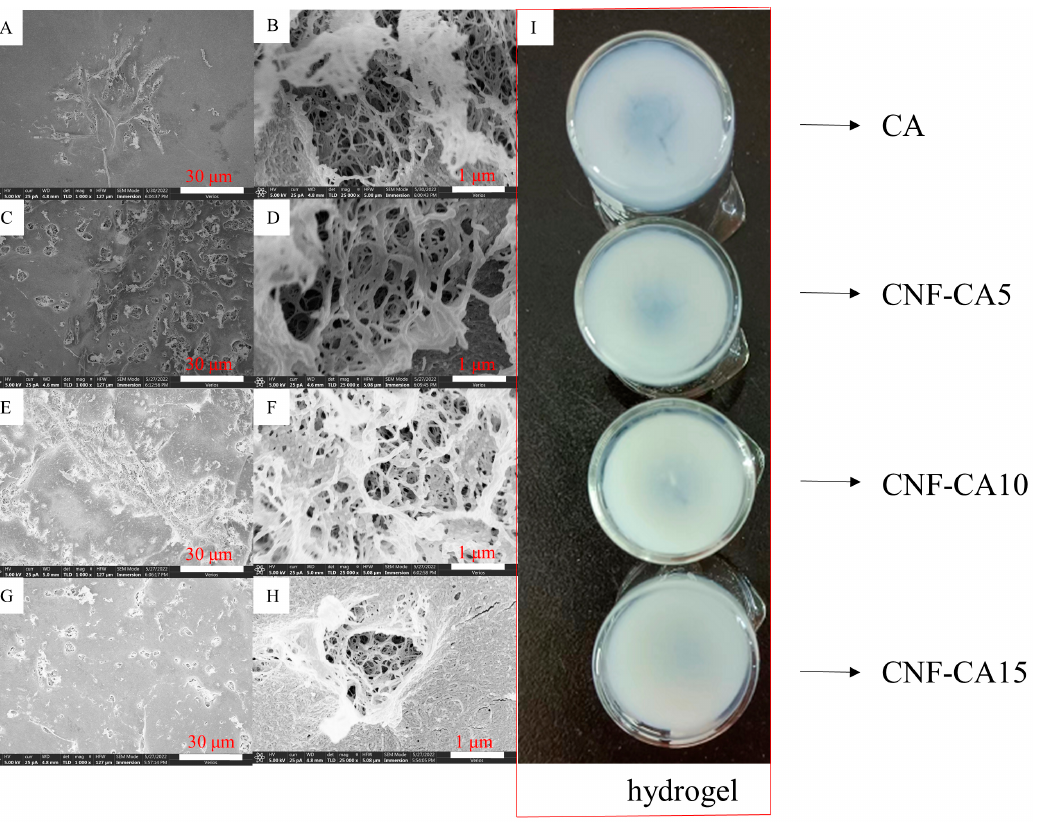
Figure 6. SEM images of composite cellulose aerogels (( A , B ) CA; ( C , D ) CNF-CA5; ( E , F ) CNF-CA10; ( G , H ) CNF-CA15)) and macroscopic pictures of corresponding hydrogels ( I ).